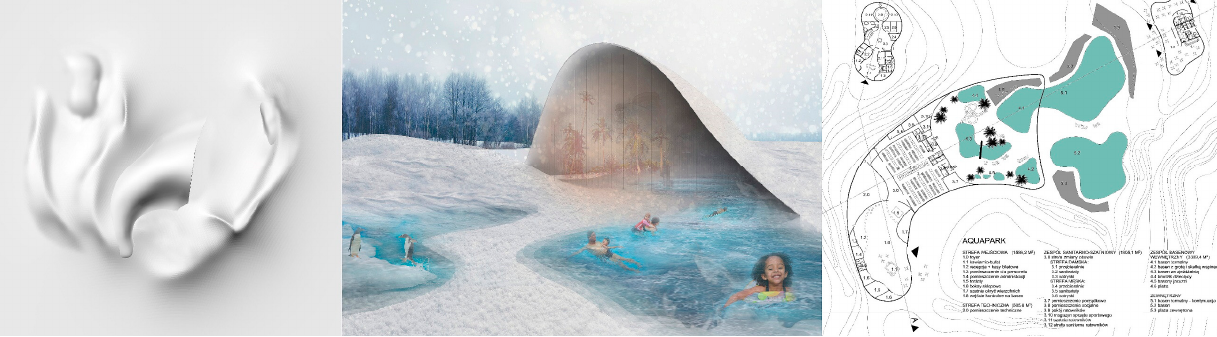
Figure 9. Retention and Recreation: Terrain model using Rhinoceros (on the left ); visualization of Aqua-park section (in the middle ); site plan (on the right ) (Magdalena Zalewska, and Iga Prüffer).